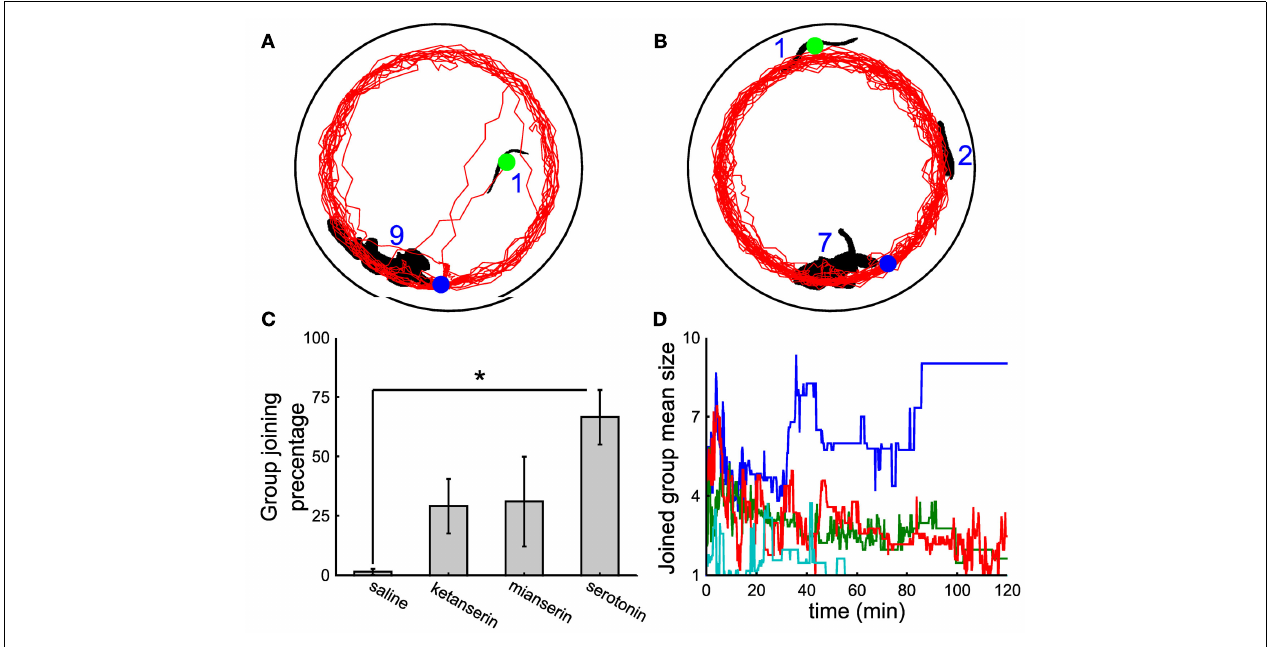
the large group of conspecifics, when leeches were injected with 300 μ l of saline solution, with 150 μ l of 1mM ketanserin or 2mM mianserin solutions, followed by another injection of 150 μ l of 400 μ M 5-HT solution, or 300 μ l of 200 μ M 5-HT solution. (D) Time evolution of the mean size of the group joined by the injected leech under the same treatments described in (C) cyan, blue, red, and green lines refer to leeches injected with a saline solution, 5-HT, mianserin, and ketanserin respectively. Student’s t -test, * p <